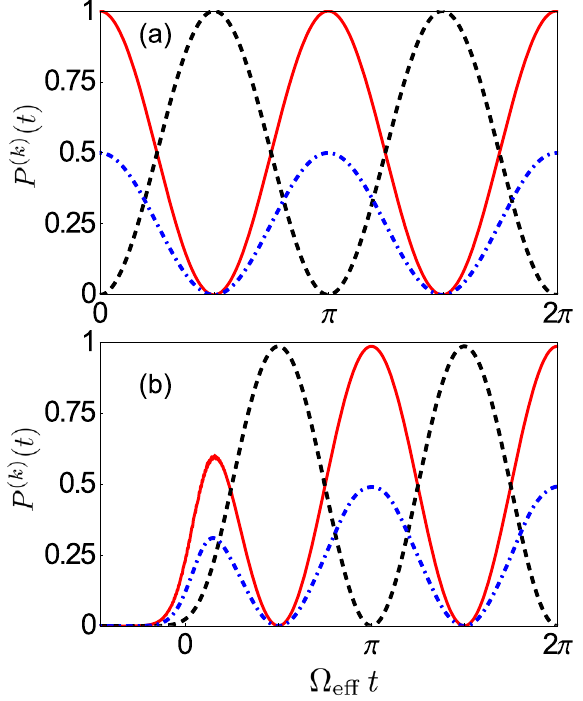
P P Figure 3. ( a ) Time evolution of the occupation probabilities P ( k ) ( t ) k = | k �� k | , for the single- k � , with ˆ ≡ � ˆ 1 A 1 1 photon states (red solid curve) and (blue dot-dashed curve), together with the probability P ( ee ) ( t ) of | � | � having both qubits simultaneously excited (black dashed curve) for the system initially prepared in the state 1 A 1 A , 0 S , g , g . Vacuum Rabi oscillations showing a reversible excitation exchange process between the | � ≡ | � qubits and the resonators are clearly visible. The joint absorption of an antisymmetric cavity photon by the π/ 2 , with the excitation probability P ( ee ) two qubits is achieved after a Rabi half period � eff t =